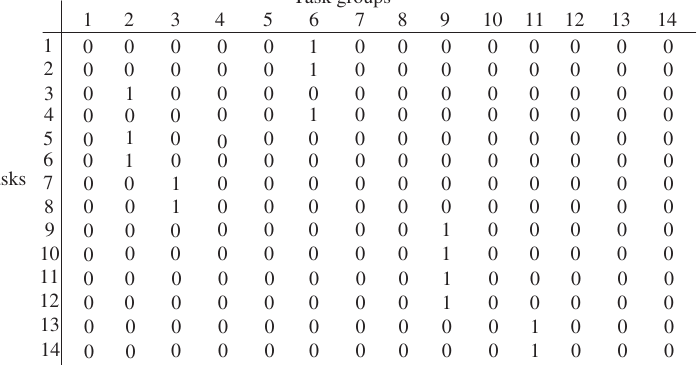
Figure 8: The Result of Task